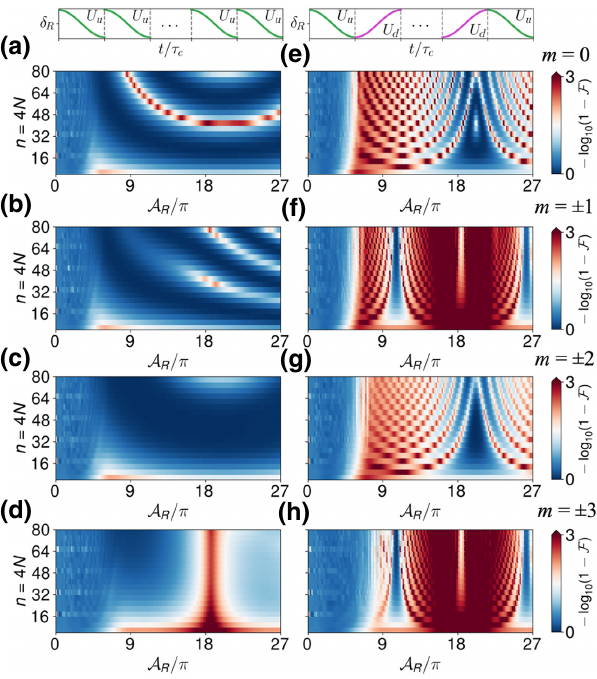
FIG. 13. Numerical results of gate infidelity 1 − F for the tra- (left panels) and balanced chirp-alternating ˜ U ( 4 N ) ditional ˜ U ( 4 N ) uu uddu (right panels) controls as those in Fig. 7, F = F ( 4 N ) , except for m (cid:2) = − 6.6 ω 85 Rb atom with nuclear HFS, g here and for a fictitious spin I = 3.5. The corresponding two-photon detuning profiles are illustrated on top of